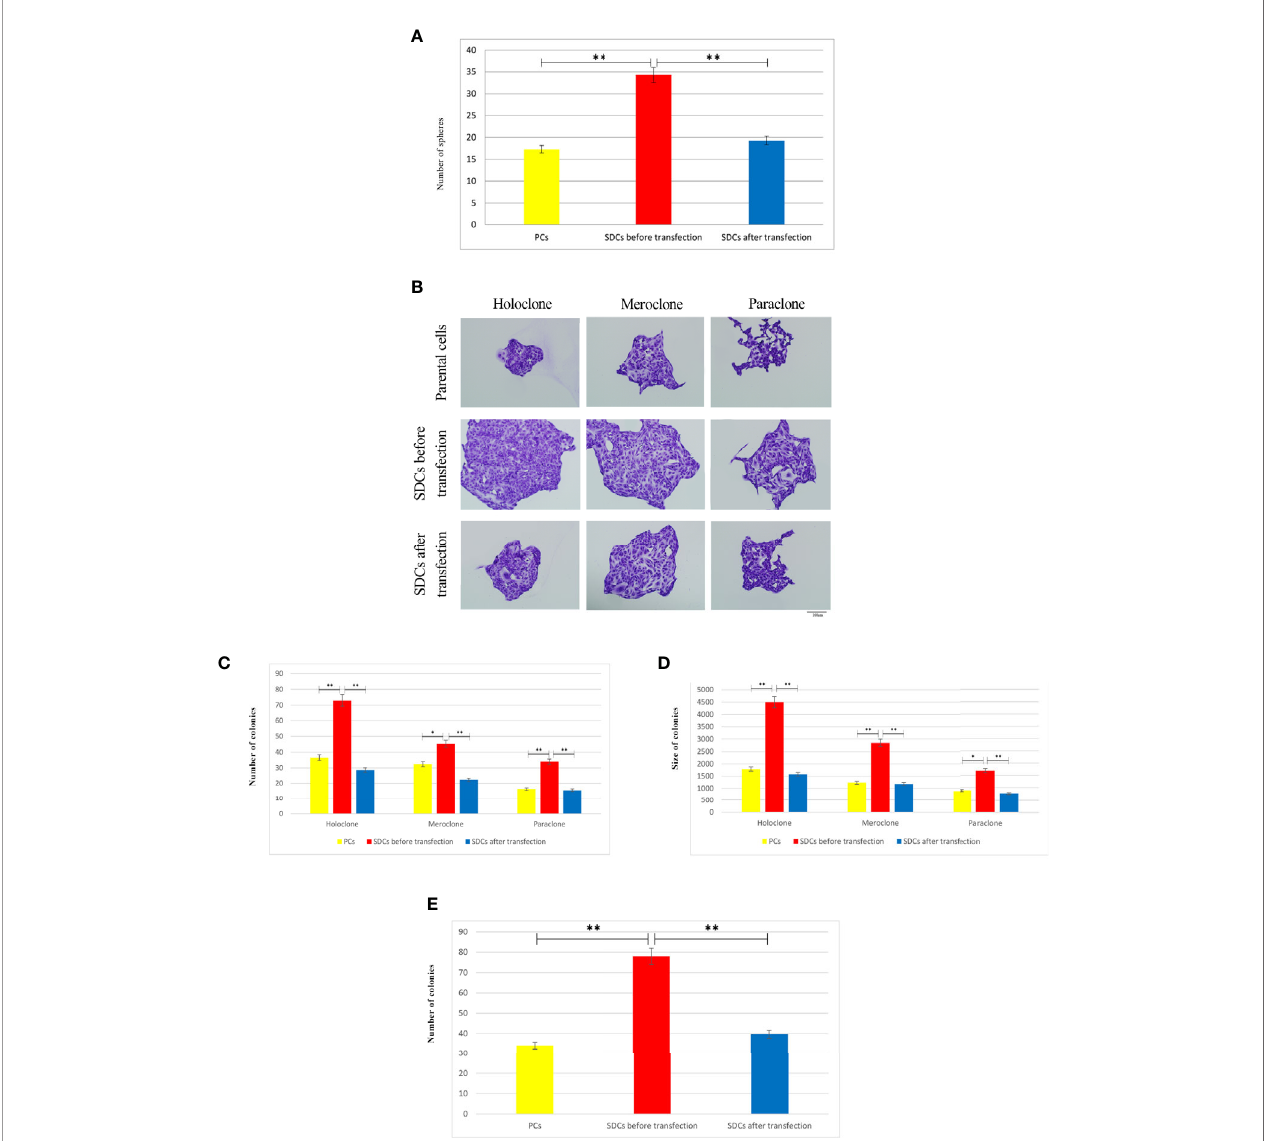
FIGURE 4 | Clonogenicity and Sphere Formation Potential of Parental Cells (PCs) and Spheroid-Derived Cells (SDCs). (A) Sphere formation capacity of SDCs was signi fi cantly higher compared to PCs and was decreased in SDCs after transfection with SiSMAD4 ( P < 0.01). The colony and sphere numbers were counted under a dissection microscope. (B) Three types of colonies termed holo, mero, and paraclones were identi fi ed during the colony formation assay in 3 cell populations, including PCs and SDCs before and after transfection with SiSMAD4. (C, D) The potential of clonogenicity was signi fi cantly higher in SDCs than PCs and was signi fi cantly decreased in SDCs after transfection with SiSMAD4. (E) The fi nal results of cell invasion assay showed that SDCs were signi fi cantly more invasive (2.27- fold) than PCs, and invasive potential was signi fi cantly decreased (1.96-fold) in SDCs after transfection of PCs with SiSMAD4. Data are represented as mean ± SD (n = 3 each). ** P < 0.01. (n = 3 each) and * P <